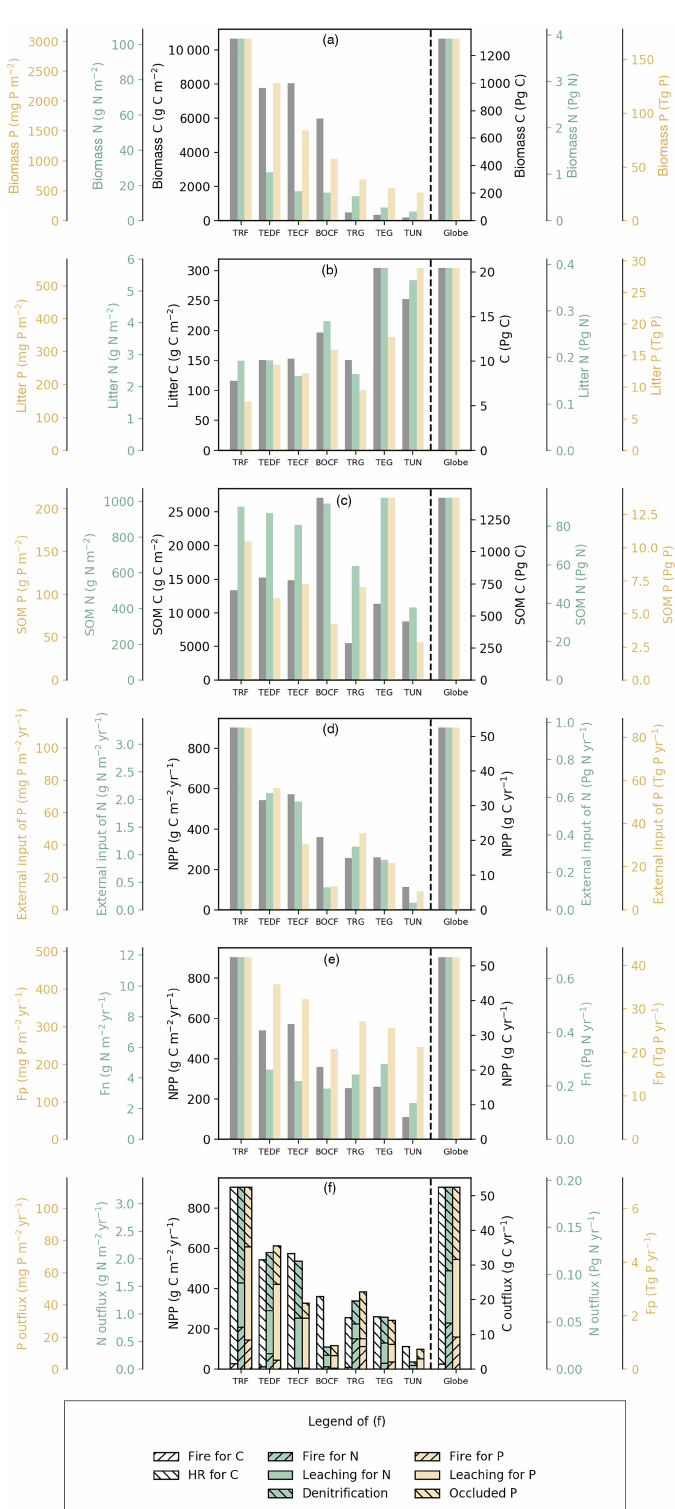
Figure 4. Pool sizes and fluxes of C (black), N (green), and P (yellow) computed from